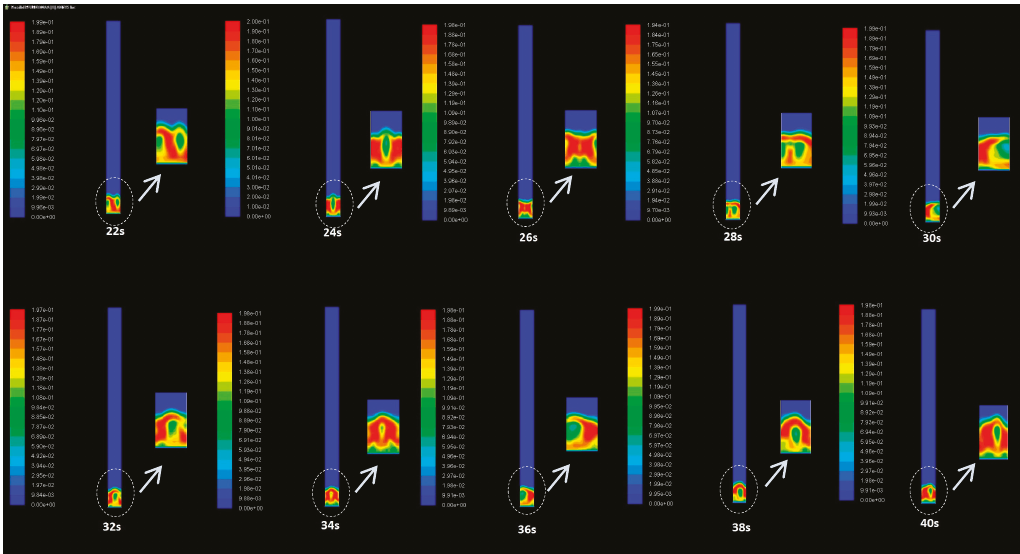
Figure 8. Solids volume fraction of Case 2 (20–40